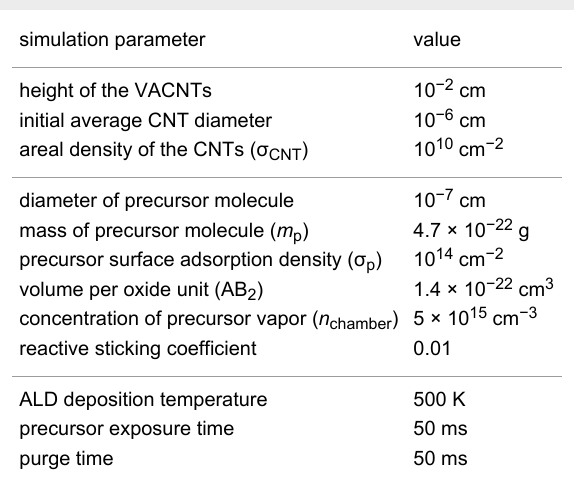
Table 1: Default parameters for the